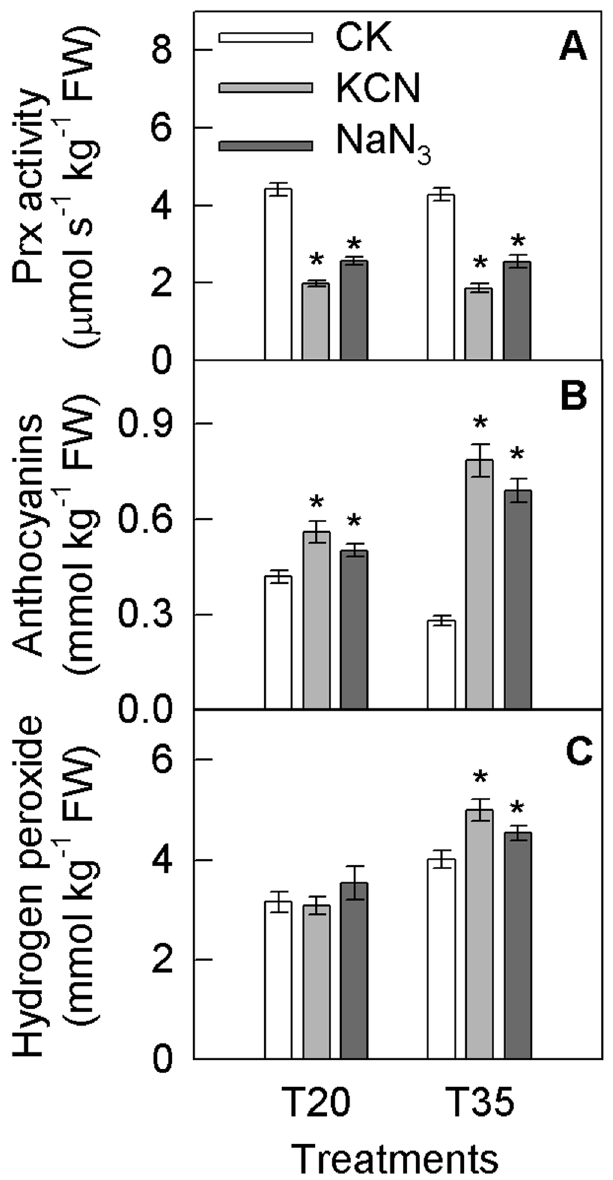
Figure 7. Class III peroxidase (Prx) activities ( A ) and anthocyanin ( B ) and hydrogen peroxide ( C ) concentrations in the peels of plum fruits exposed to different treatment in the dark. Each data point represents mean ± SE (n = 5). The asterisk indicates a significant difference between two temperature treatments at P < 0.05, t -test.